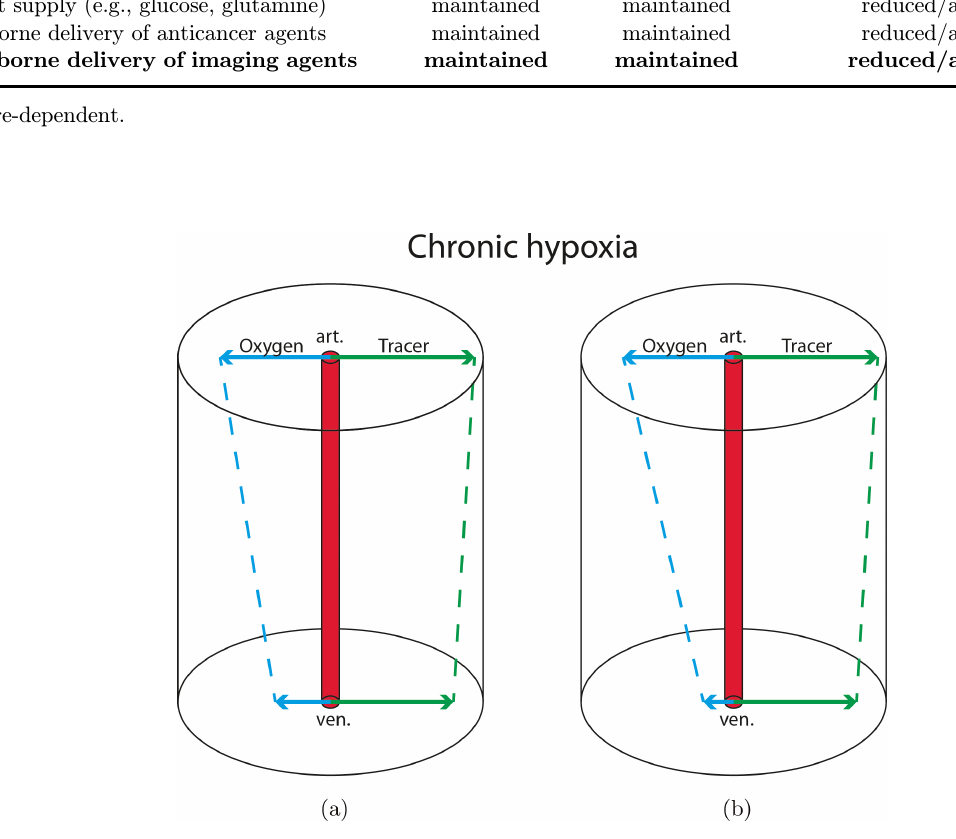
Fig. 2. Chronic hypoxia. Schematic representation of the radial di®usion distances for oxygen (blue) and hypoxia tracer (green) within a tissue cylinder surrounding a straight tumor capillary running from the arterial (art.) to the venous end (ven.) (a) Normoxemic conditions combined with enlarged di®usion distances leading to di®usion limited chronic tumor hypoxia. (b) E®ect of anemia (combined with enlarged di®usion distances) on the oxygen and tracer di®usion distances in chronic hypoxia. The broken lines represent the critical di®usion distances for both